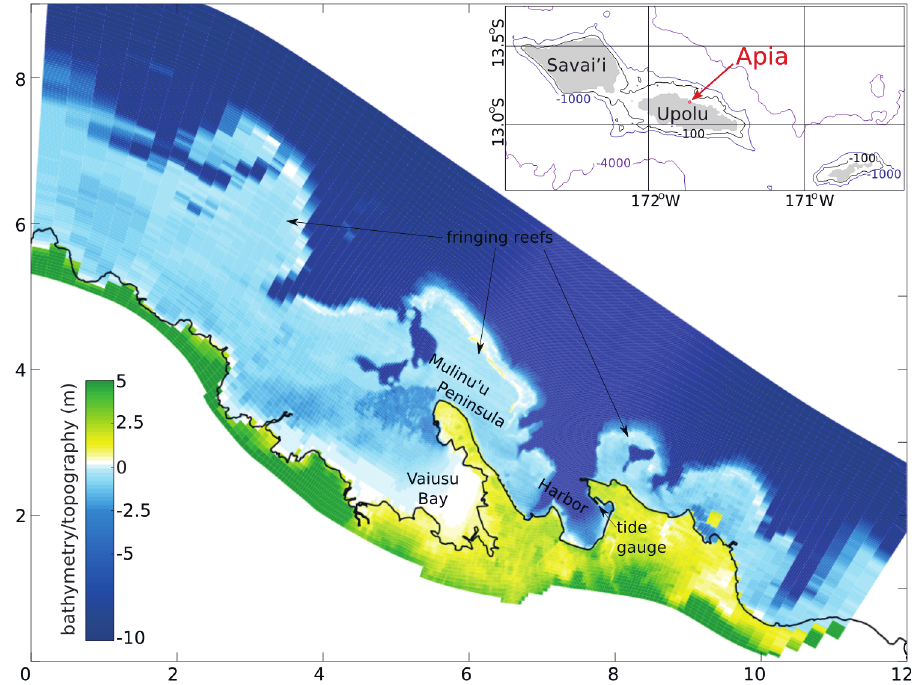
Figure 1. Location map of Apia in the Samoan Archipelago (inset, upper left) and the Apia Model’s curvilinear grid and bathymetry/topography (main panel) with key geographical features labeled. Note grid resolution varies from approximately 100 m near the boundaries to approximately 10 m near the center. The numbers on the x- and y-axes indicate distance in